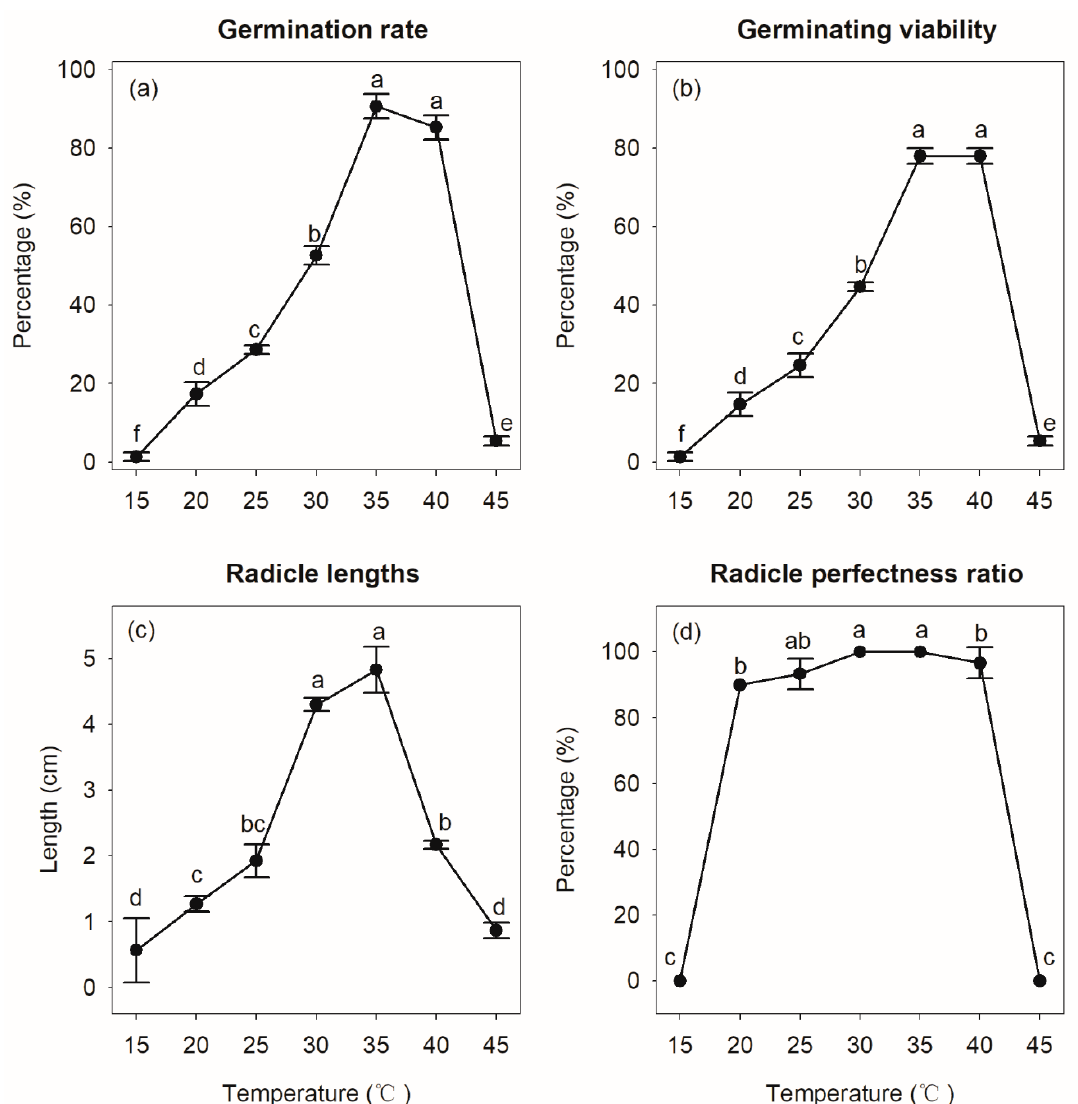
Figure 4. Effects of different temperatures on indicators. Different letters indicate significant difference ( p <